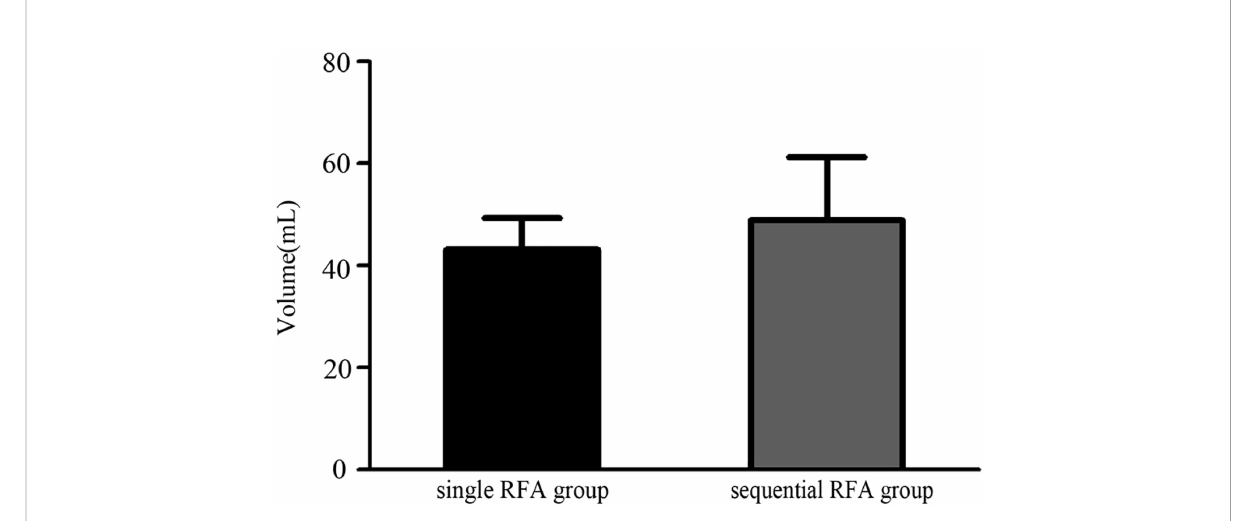
FIGURE 5 The difference of the volumes of the large solid thyroid nodules between single RFA group and sequential RFA